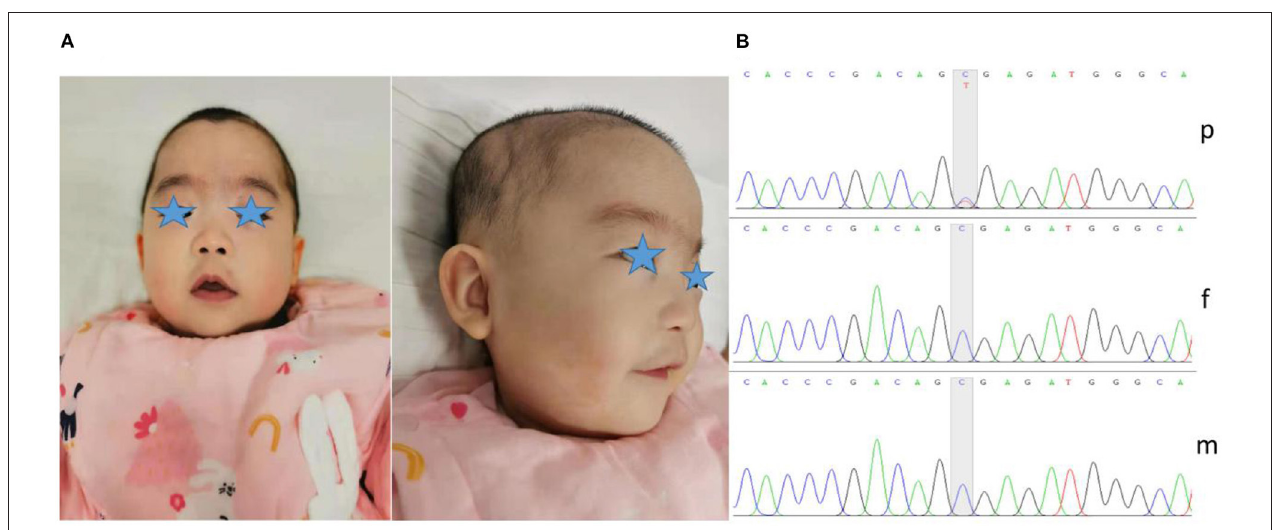
FIGURE 1 | Dysmorphic features and variant analysis. (A) Photographs of our patient at 7 months showed microcephaly, micro/retrognathia, hypertelorism, depressed nasal bridge, low-set ears and hypertrichosis. (B) The proband carried the c.1210C > T variant in ASXL1 (p), leading to a premature stop codon; however, her parents harbored no detectable variants (f and